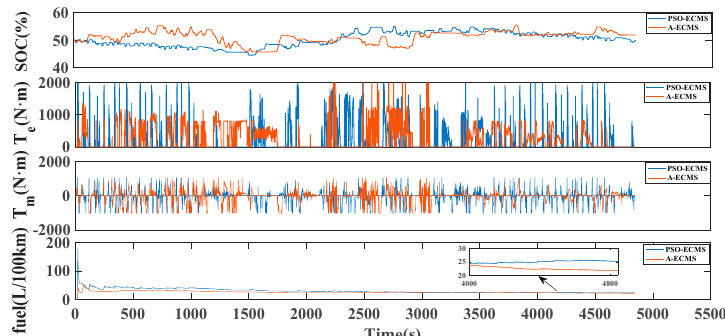
Figure 22. The simulation results of PSO-ECMS and A-ECMS under verification driving cycle.